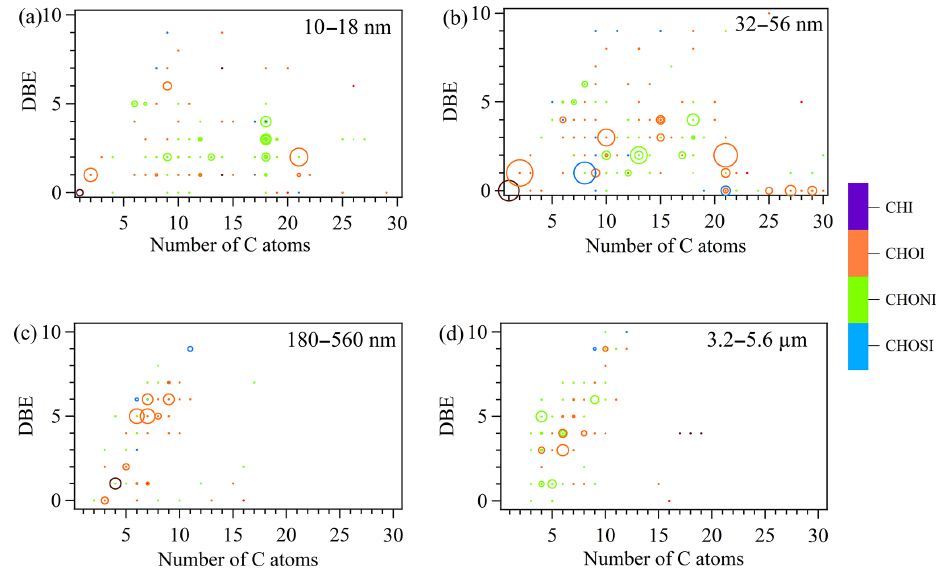
Figure 4. DBE vs. C atom number diagrams of iodinated OC formulas with intensity > 1 . 00 × 10 7 in the four size bins. The color bar denotes the elemental groups of assigned formulas. The size of the circles reflects the relative intensities of molecular formulas on a logarithmic scale.